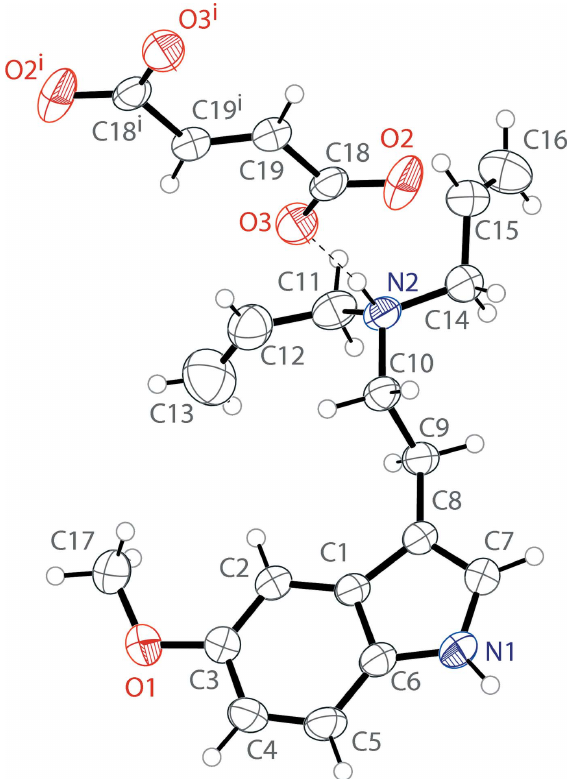
Figure 2 The crystal packing of bis(5-methoxy- N , N -diallyltryptammonium) fuma- rate, viewed along the b axis. The N—H (cid:2)(cid:2)(cid:2) O hydrogen bonds (Table 1) are shown as dashed lines. Hydrogen atoms not involved in hydrogen bonding are omitted for clarity.